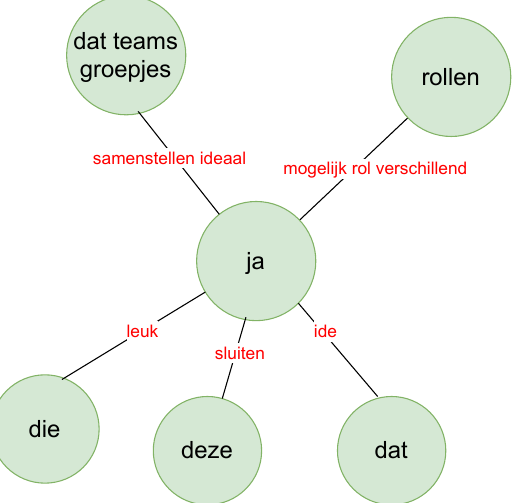
Figure 10. Part of the knowledge graph of the teacher in the red phase (zoomed in).